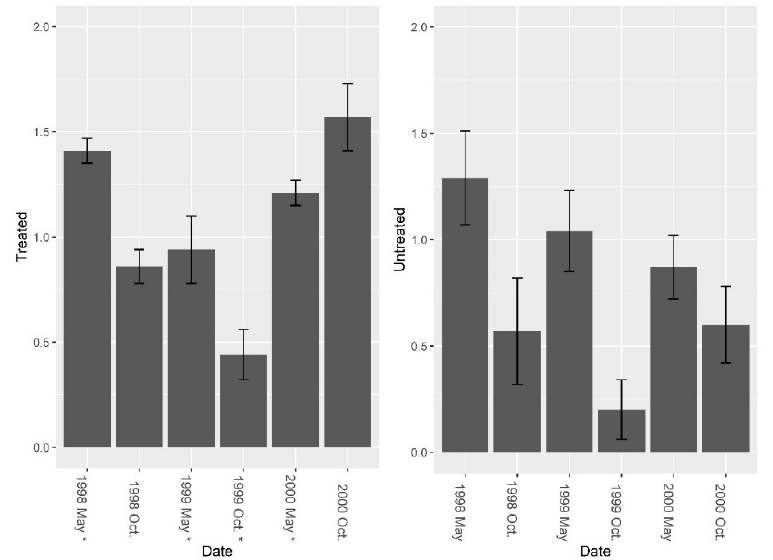
Figure 8. Mean (±1 SE) Shannon diversity indices (excluding fire ants) collected from burrow vacuuming at five pairs of treated and untreated study sites at CSJFTC, 1998–2000. Pre-treatment species diversity (excluding fire ants) was not significantly different between sites (F = 0.44, df = 4, P = 0.543), but a post-treatment effect was observed (F 1, 7 = 9.31, P = 0.019) between treated and untreated sites. Asterisks on the x-axis indicate when treatments occurred.